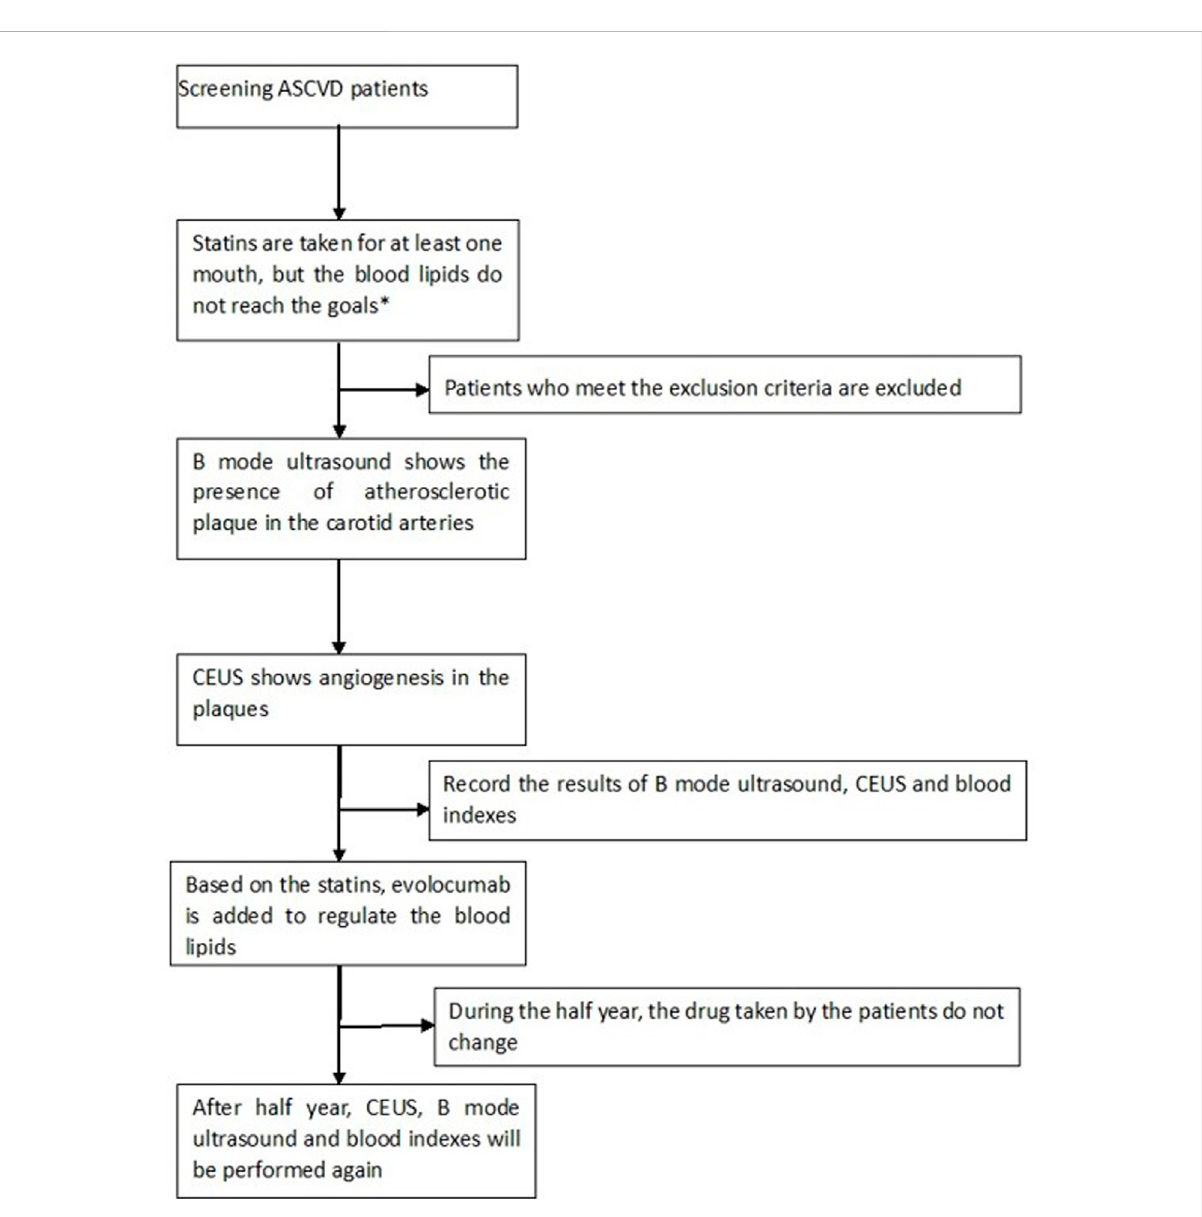
FIGURE 1 Our target goal for blood lipids was LDL-c < 1.8 mmol/L; CEUS: contrast-enhanced ultrasound; ASCVD: arteriosclerotic cardiovascular disease; exclusion criteria: allergies to albumin or SonoVue; pregnancy; severe liver, kidney or thyroid dysfunction; severe arrhythmia, heart failure or hypertension; and diabetes patients with poor control of blood glucose who had used evolocumab